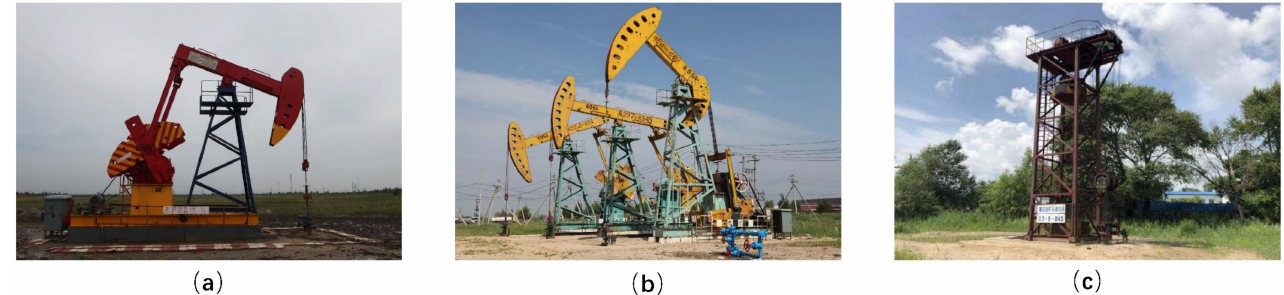
Figure 4. Oil wells in the field survey: ( a ) a single beam-pumping well; ( b ) a cluster of beam-pumping wells; ( c ) an inoperative belt-pumping